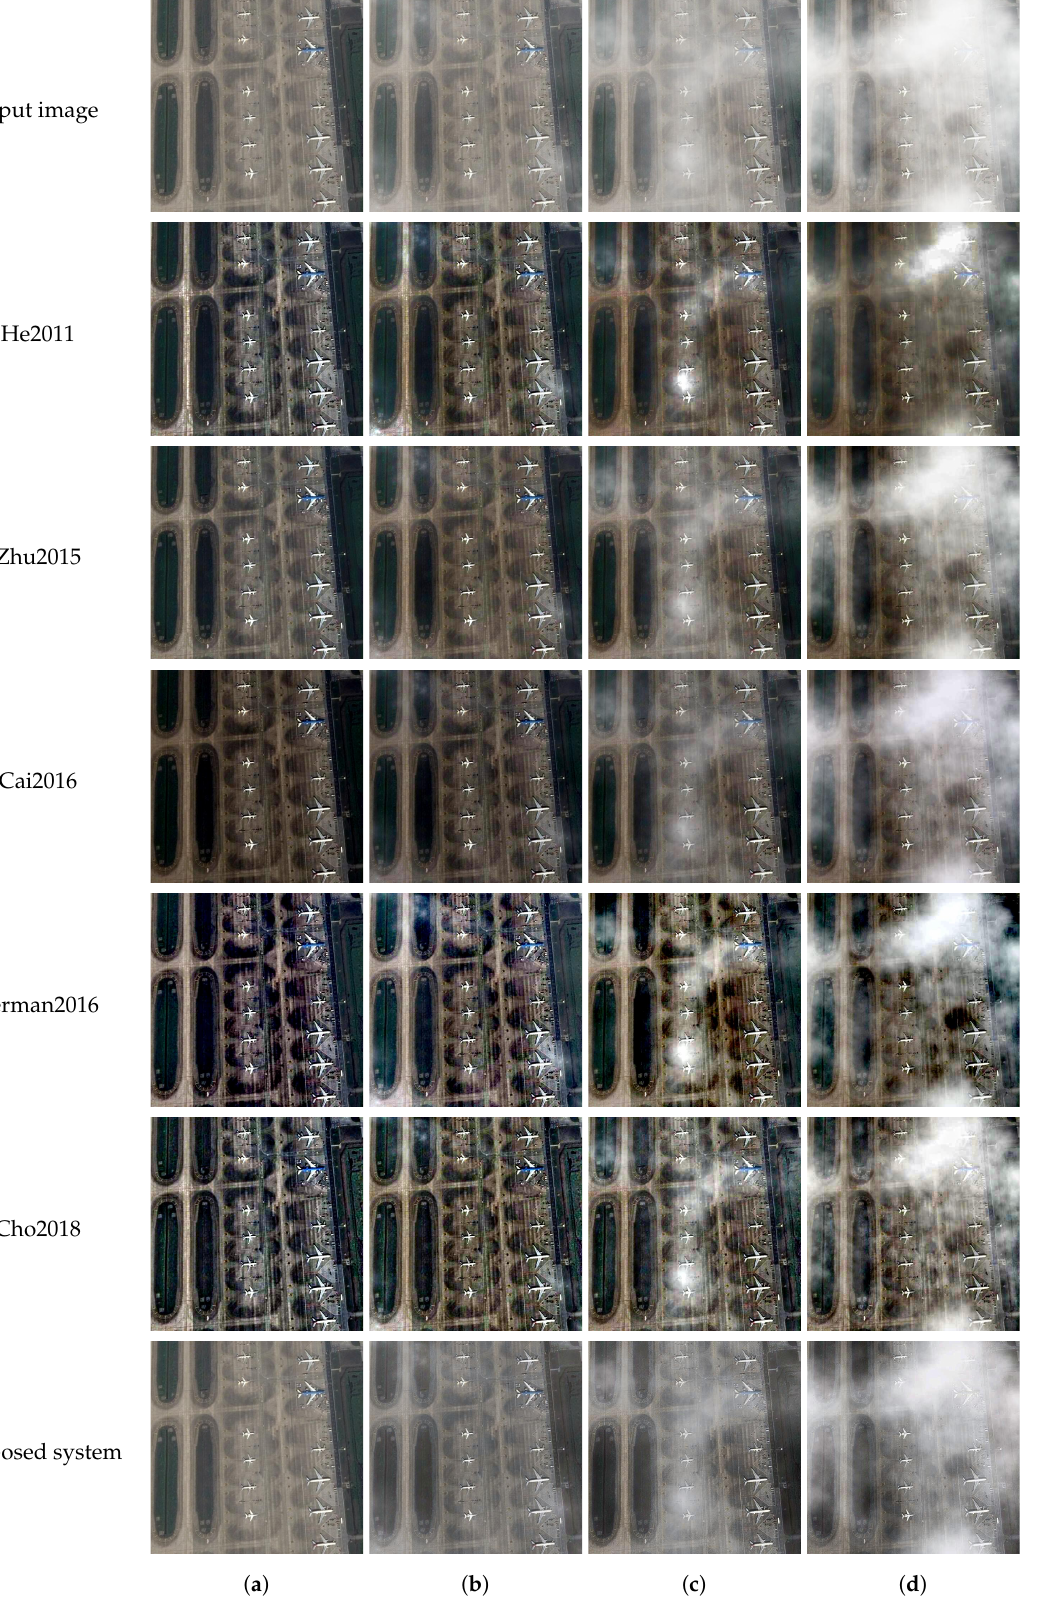
Figure 9. Qualitative evaluation of different image dehazing methods on an aerial image depicting an airport. ( a – d ) correspond to four haze conditions: haze-free, thin, moderate, and dense. The ρ I values of input images are 0.8771, 0.9026, 0.9279, and 0.9594, respectively. He2011, Zhu2015, Cai2016, Berman2016, and Cho2018 denote five benchmark methods of He et al. [9], Zhu et al. [11], Cai et al. [13], Berman et al. [12], and Cho et al.